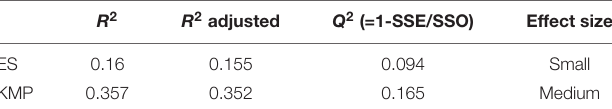
TABLE 6 | R 2 and Q 2